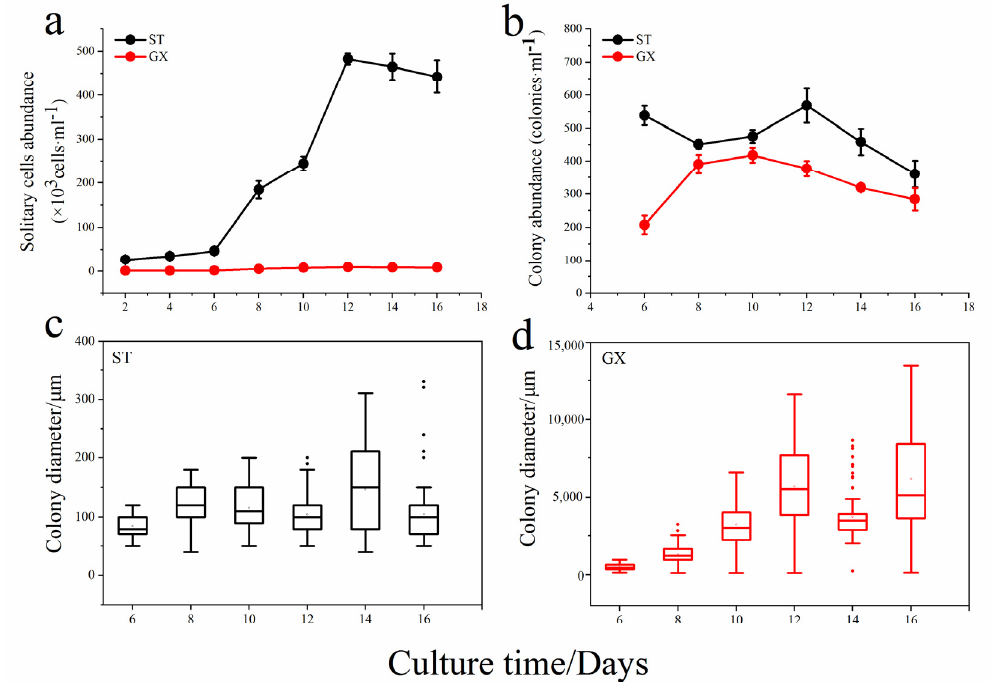
Figure 3. Growth curves of the two P. globosa strains. Abundances of solitary cells ( a ); colony abundance ( b ); colony diameter of ST ( c ); colony diameter of GX ( d ). ST represents P. globosa originally collected in Shantou and GX represents P. globosa originally collected in Guangxi.